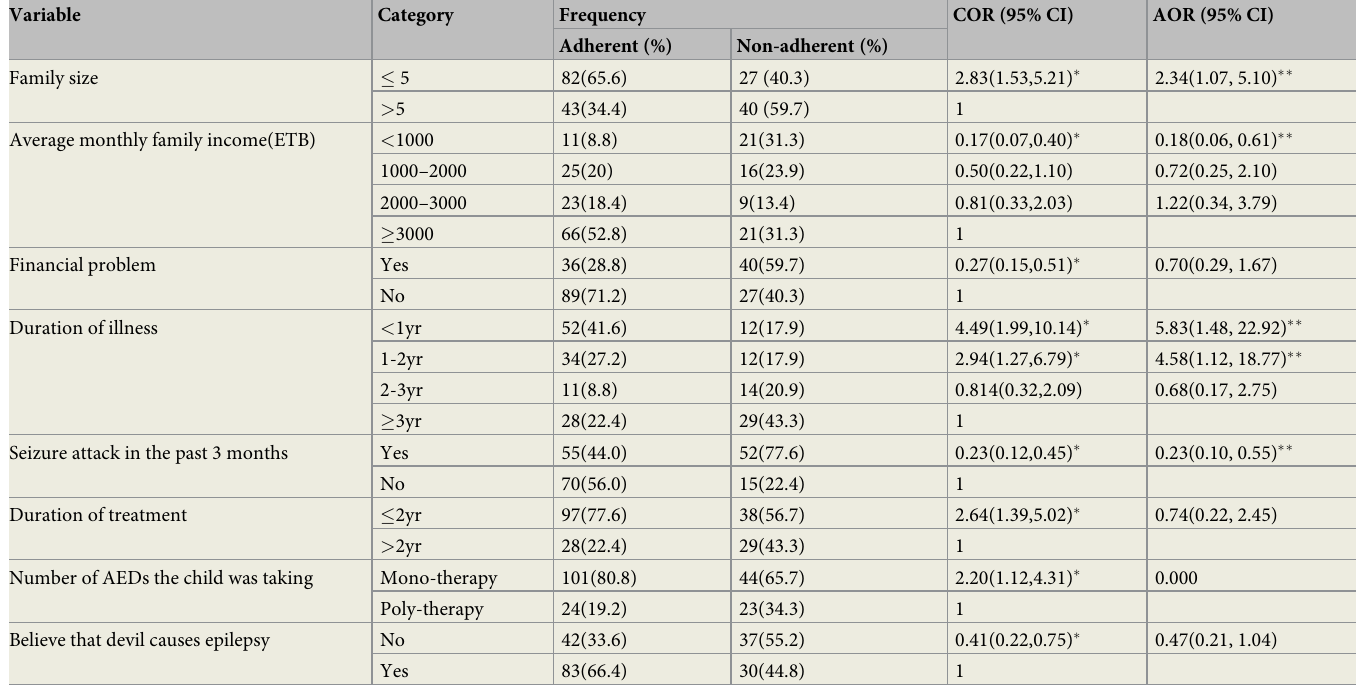
Table 4. Bi-variable and multivariable analysis of factors associated with AEDs adherence among children with epilepsy (N =